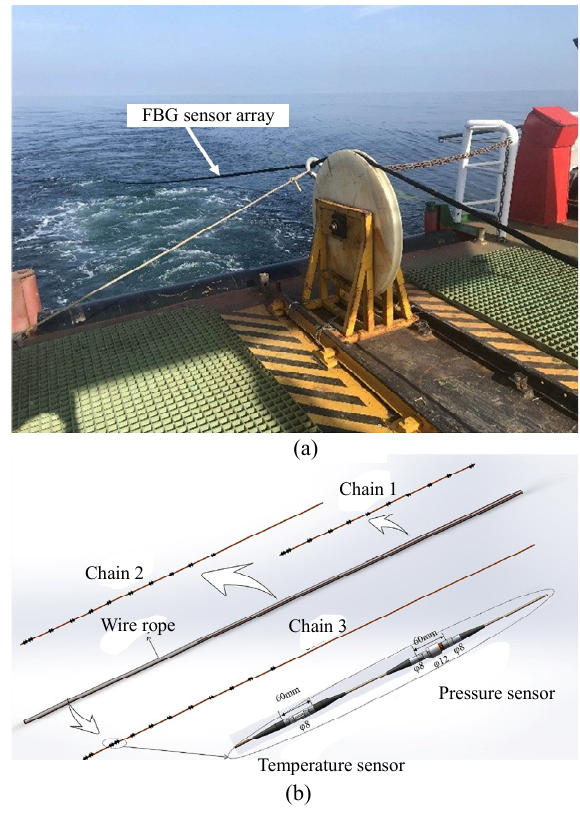
Fig. 8 Sensor array physical picture (a) and diagram (b).